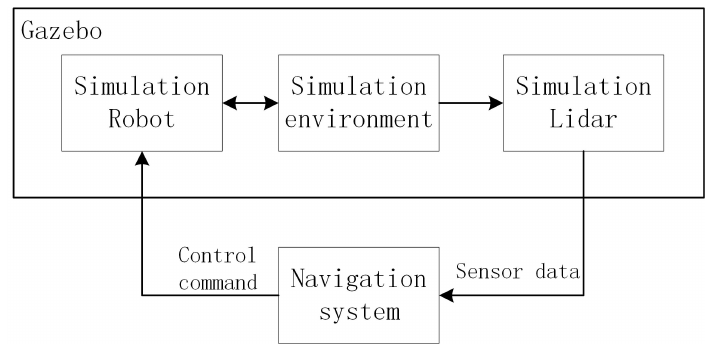
Figure 11. The simulation